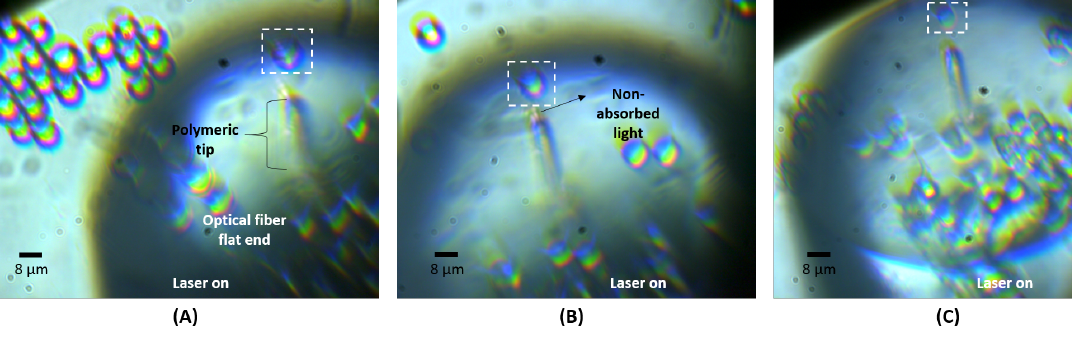
Figure 4. Video frames showing ( A ) a polystyrene; ( B ) a PMMA microparticle and ( C ) a living yeast cell stably trapped in front of the fabricated polymeric tip embedded in de-ionized